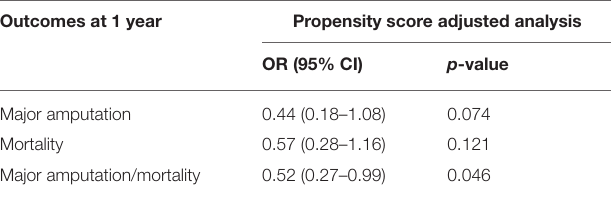
TABLE 2 | Propensity score adjusted analysis of outcomes in patients with Rutherford IIb ALI examined with CTA prior to revascularization or